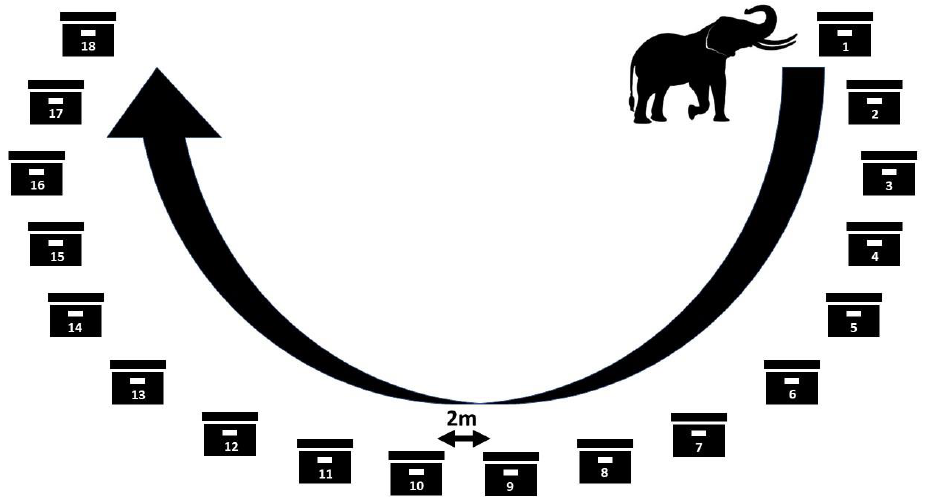
Figure 3. Diagrammatic view of a cafeteria experiment. Elephants were brought to the first feeding trough, after which they were left alone for five minutes to explore the eighteen feeding troughs. Each trough had 50 g of a randomly selected crop or plant type placed inside of it.